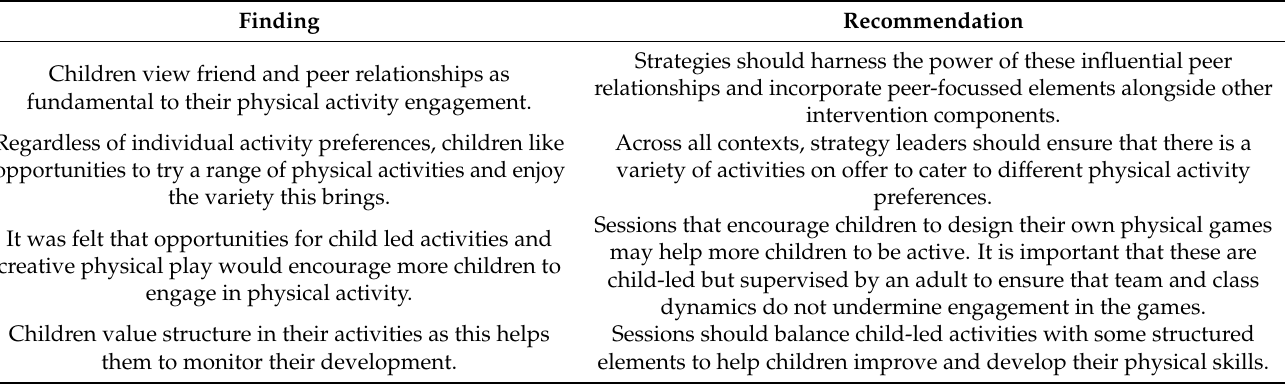
Table 7. Key findings and recommendations for future strategies to increase primary school children’s physical activity